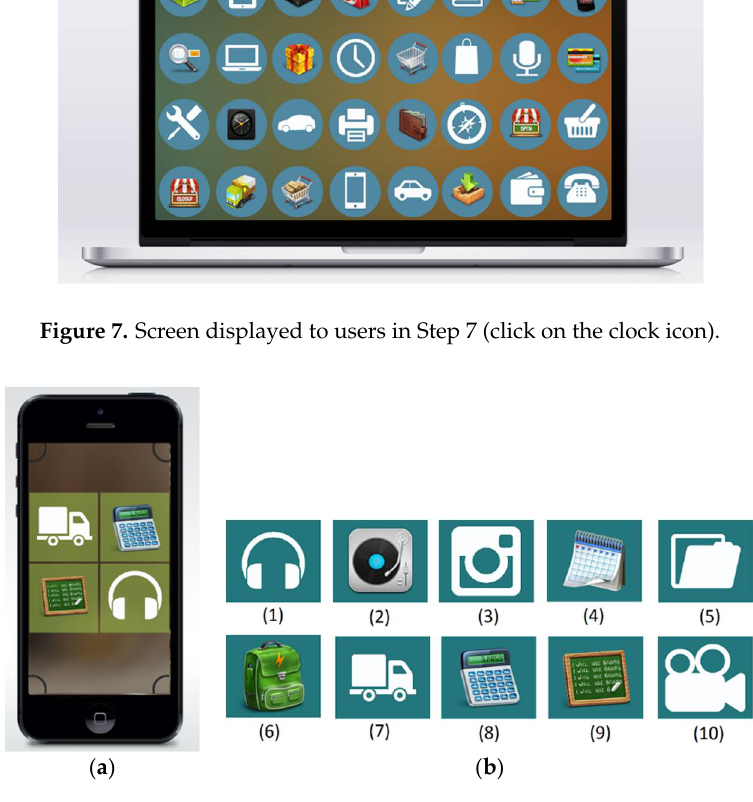
Figure 8. ( a ) Screen displayed to users in Step 8 (recall the icons); and ( b ) icons to choose from the one displayed.